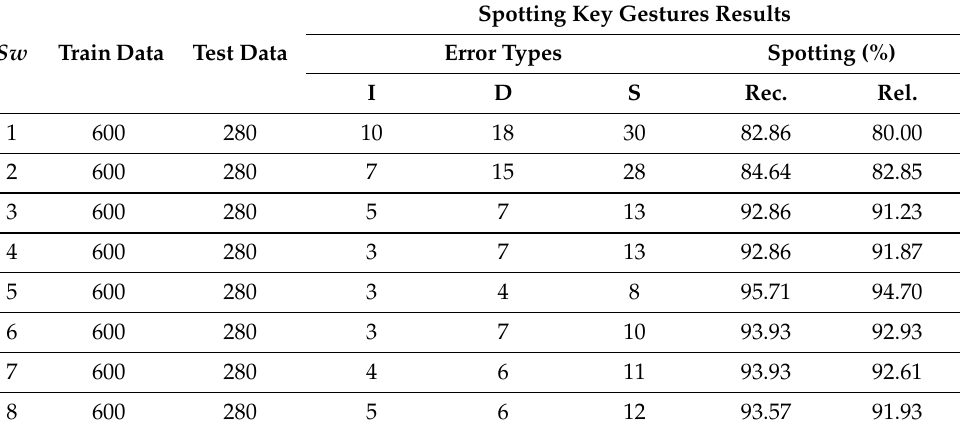
Table 2. Results of meaningful gesture spotting using HMM and recognition using DNN with various Sw ranging from 1 to